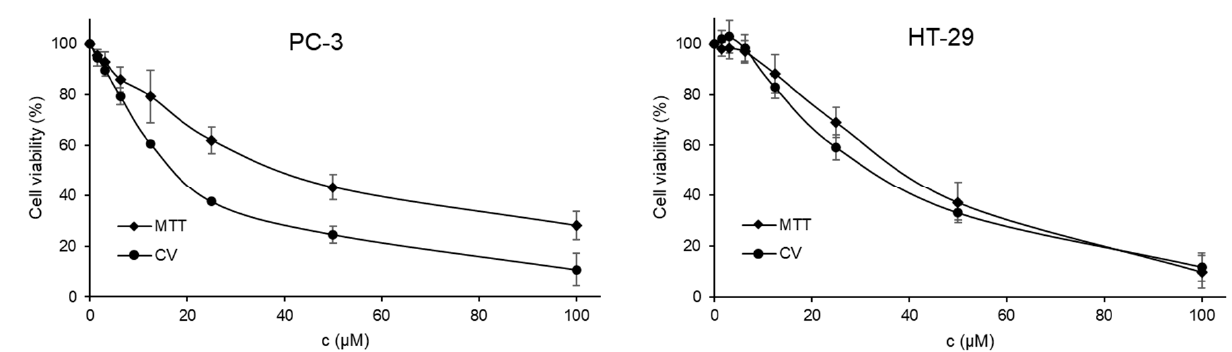
Figure 10. Dose-dependent response of PC-3 and HT-29 cells treated with 1 . IC 50 [ μ M] on: PC-3 40.52